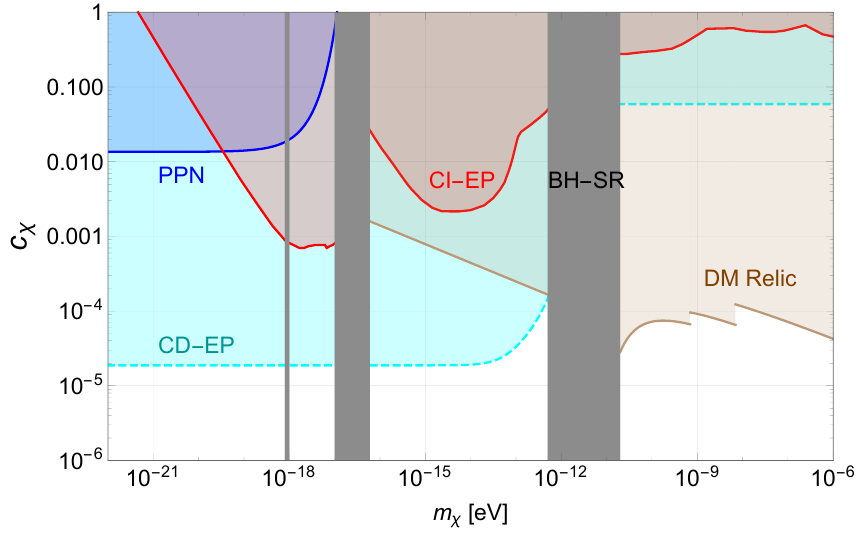
Figure 1 . Observational upper bound on the modulus coupling c (cid:31) = ~ d ~ q + 3 ~ d g as a function of the modulus mass m (cid:31) . The gray regions are excluded by the blackhole superradiance (BH-SR) [46]. The cyan region and the red region are excluded, respectively, by the composition-dependent [37, 47] and composition-independent [48, 49] equivalence principle (CD-EP and CI-EP) tests. Constraints on the parametrized post-Newtonian (PPN) parameters [34, 42{45] exclude the blue region, which applies not only for a generic modulus, but also for a metrical modulus respecting the equivalence principle. The dark matter relic abundance constrains the modulus misalignment, excluding the brown